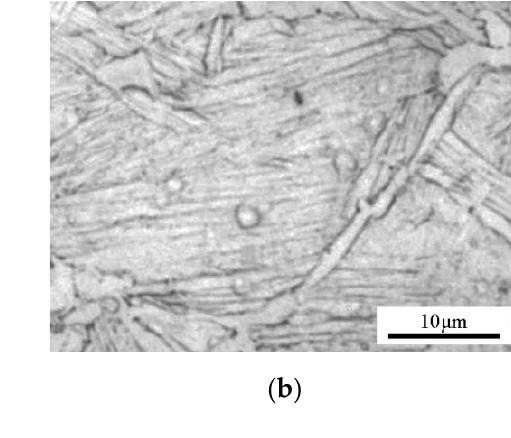
Figure 8. Weld surface morphology: ( a ) positive forming and ( b ) back forming.